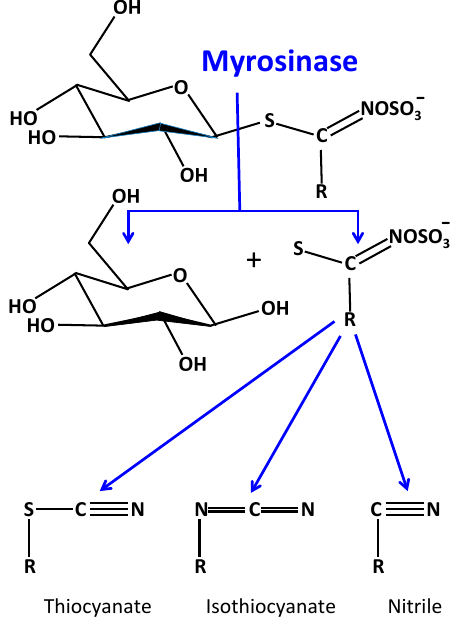
Figure 1. Generic structure of the Glucosinolates showing glucose, sulphation and the aglycone side chain (R) used to categorize the aliphatic, indolic or aromatic glucosinolates.